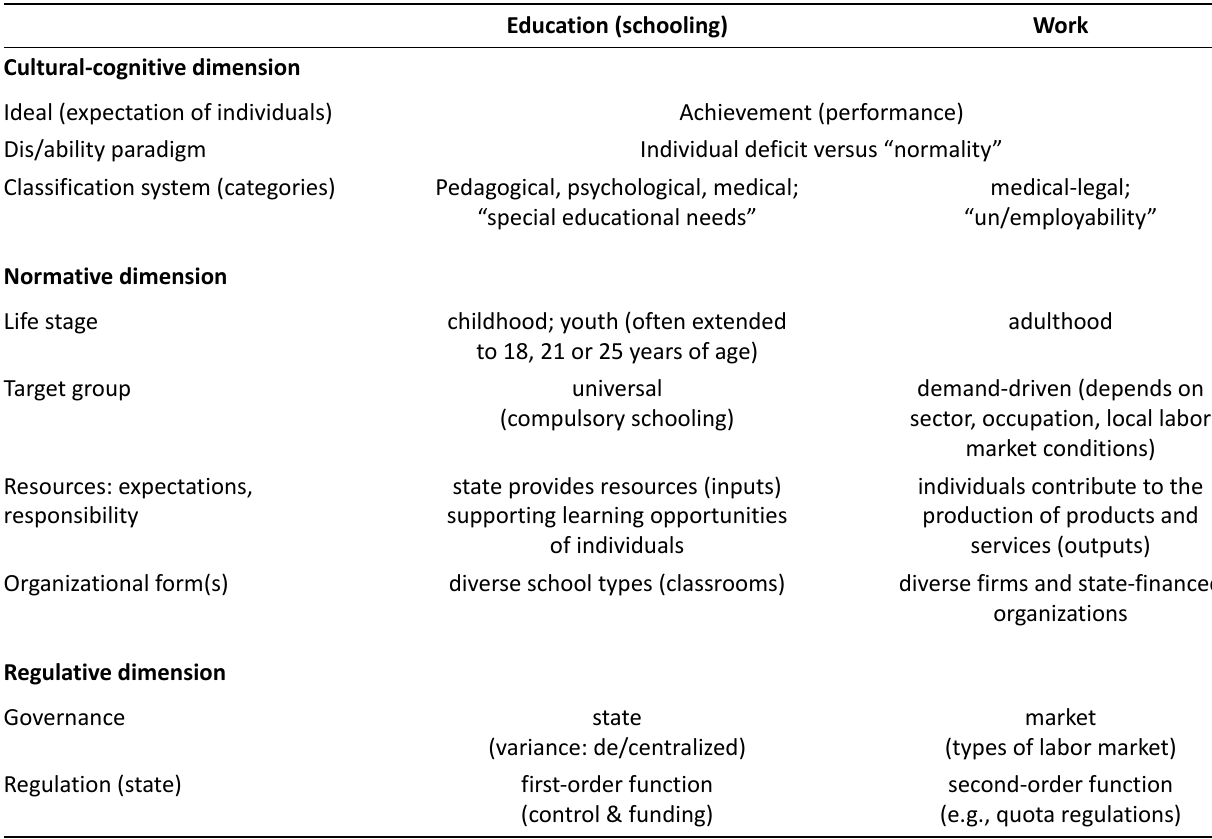
Table 1. Institutional dimensions of education and